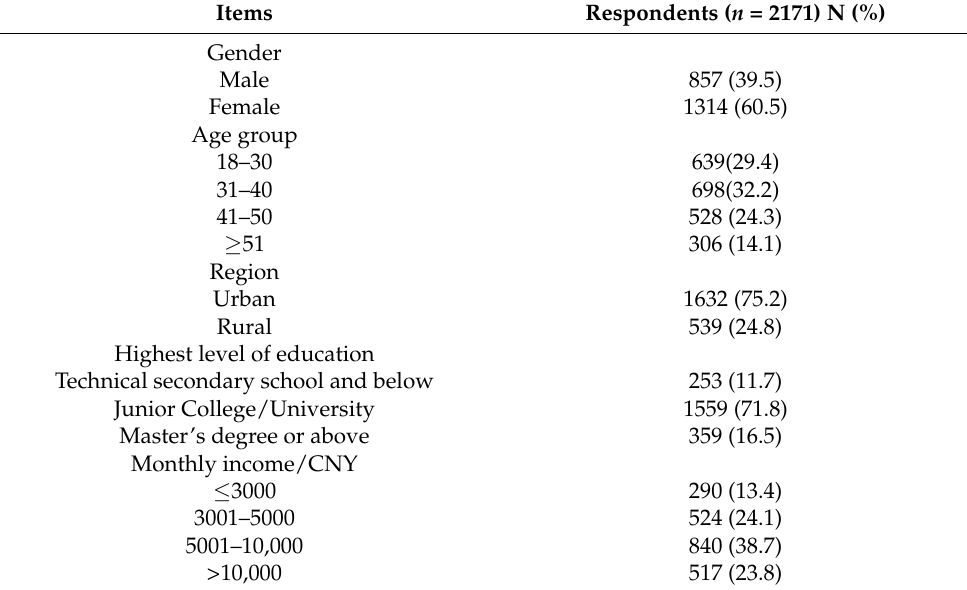
Table 1. Demographic characteristics of